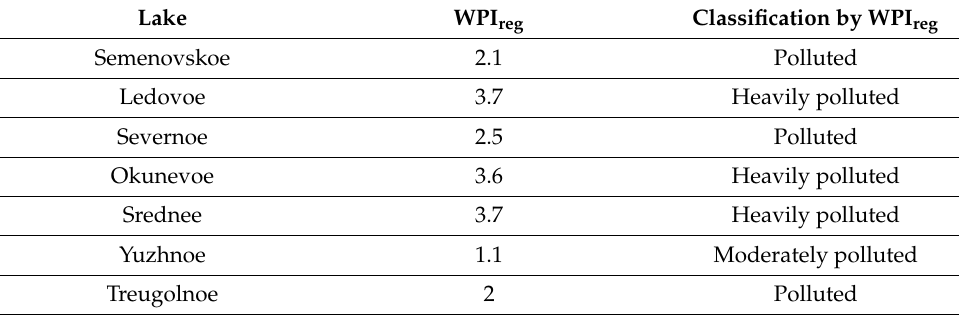
Table 4. The regional water pollution index (WPI reg ) of the Murmansk lakes. Lake WPI